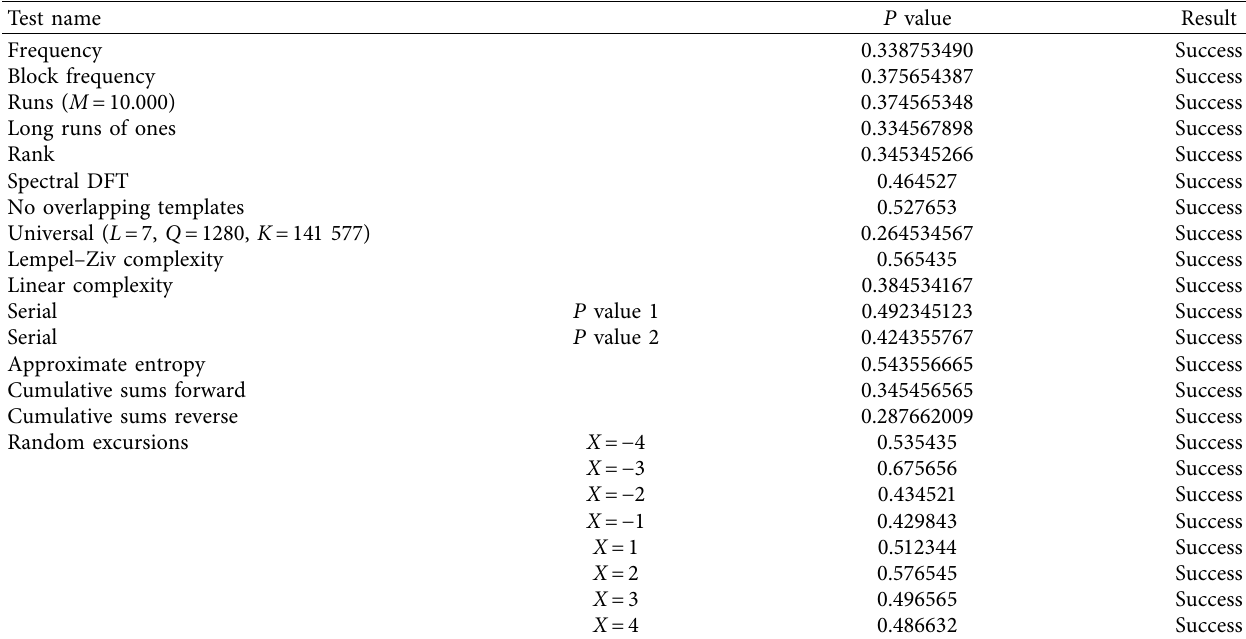
Table 6: Result of the NIST (SP800) test suite.